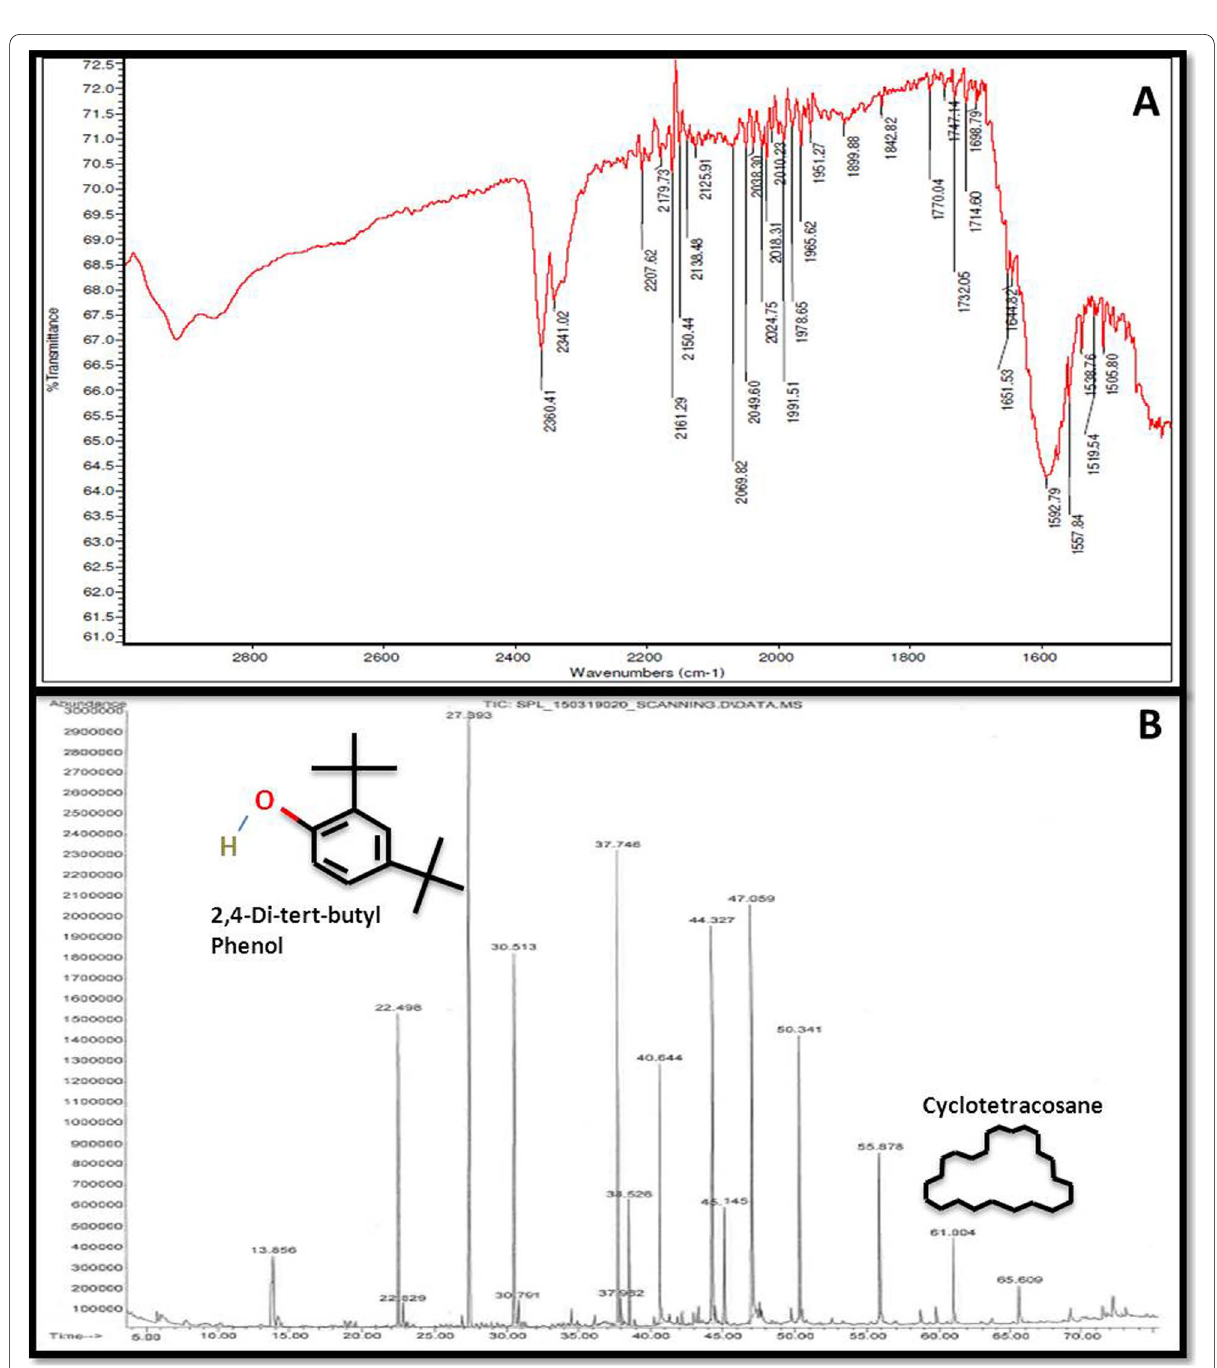
Fig. 7 A The FTIR spectra of coal sample. B The fragmentation pattern of coal